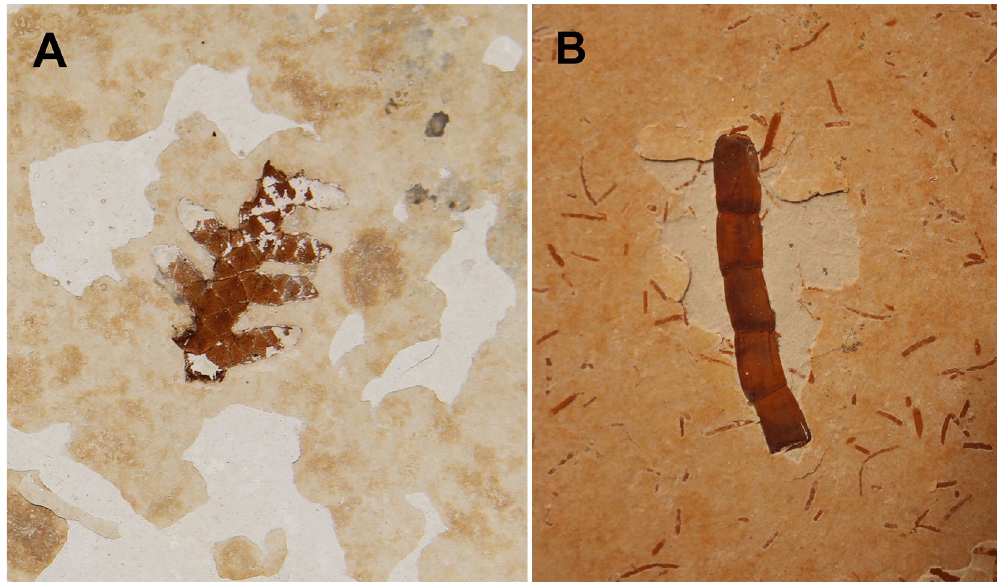
Figure 7. Brachyphyllum sp. and Pseudofrenelopsis sp. ( A ) Brachyphyllum sp. recovered from the controlled excavation; ( B ) Pseudofrenelopsis sp. recovered from the controlled